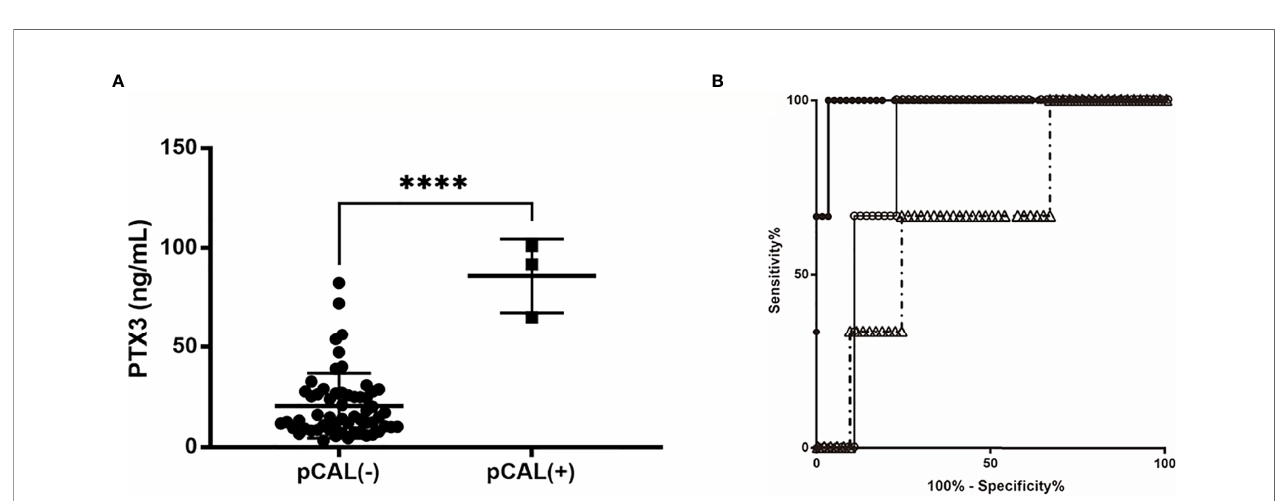
FIGURE 3 | AUC and predictive power of the biomarker candidate levels at the time of admission. (A) Unpaired Student t-test. Comparison of the PTX3 level in patients with or without pCAL. **** p < 0.001. (B) ROC curves comparing the sensitivity and speci fi city of certain variables and CAL formation; the AUC values of PTX3, NT-proBNP and Presepsin were respectively 0.9885±0.014 (95% con fi dence interval [CI]: 0.961 to 1.00, p = 0.005), 0.8563±0.054 (95% CI: 0.7513 to 0.9614, p = 0.039), and 0.6667± 0.148 (95% CI: 0.3765 to 0.9568, p = 0.33). The cut-off value of 69 ng/ml to predict subsequent CAL had a speci fi city of